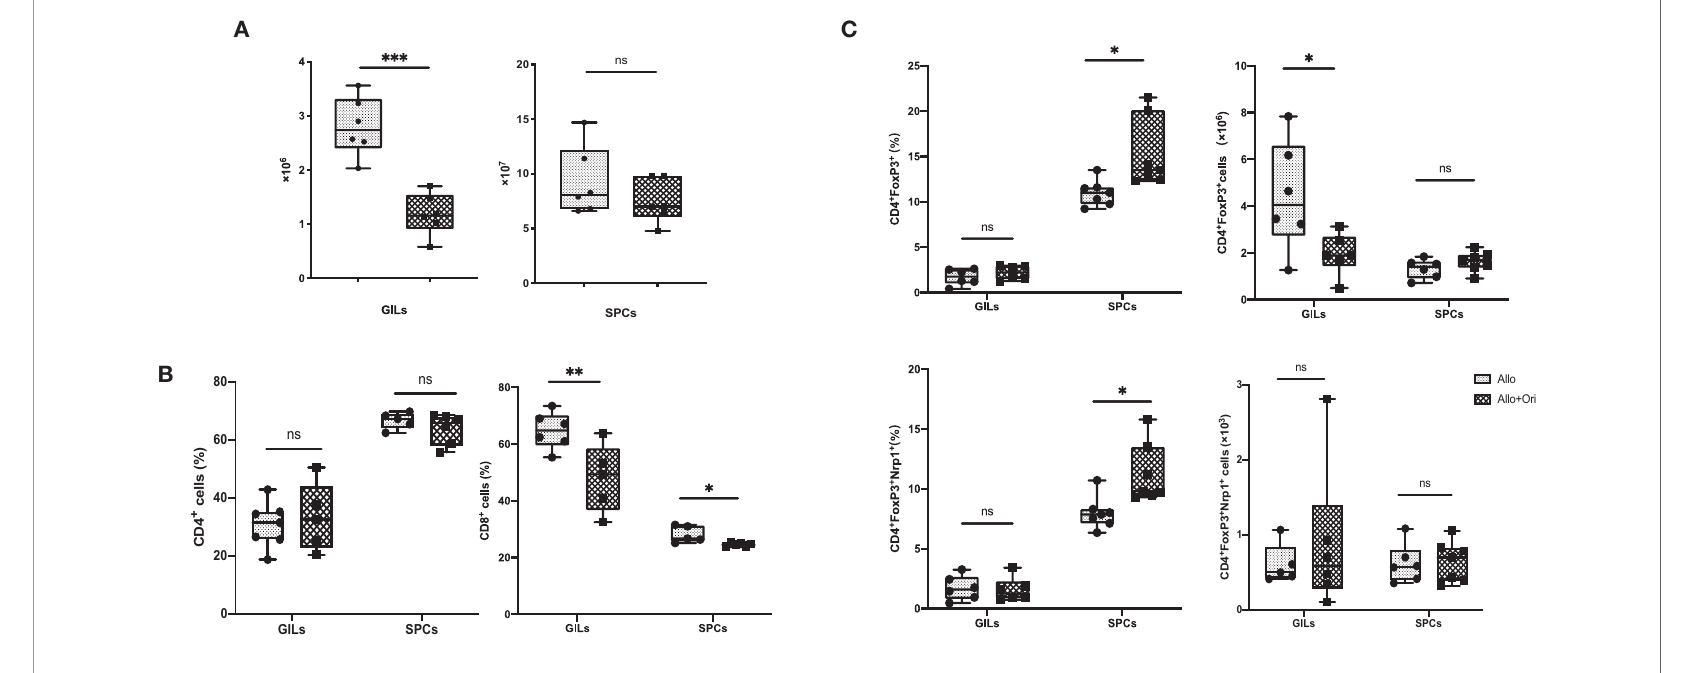
FIGURE 3 | The management of Ori induced alternation of the in fi ltrating T cells and Treg in GILs and SPCs. Spleens and cardiac grafts were harvested on POD7 from vehicle control (Allo) and Ori-treated (Allo + Ori) groups. SPCs and GILs were isolated, multiply stained with mAb, and then assessed by FCM. Stained GILs and SPCs were gated on lymphocyte live cells. Gating strategy is shown in Supplementary Figures S1, S2 . (A) The total cell numbers of the SPCs and GILs in Allo and Allo + Ori groups. (B) The frequencies and absolute numbers of CD4 + and CD8 + T cells in SPCs and GILs from Allo and Allo + Ori groups. (C) The frequencies and absolute numbers of Tregs (CD4 + FoxP3 + and CD4 + FoxP3 + Nrp1 + T cells) in SPCs and GILs from Allo and Allo + Ori groups. Values are shown as the mean ± SD; * p < 0.05, ** p < 0.01, *** p < 0.001, ns, no signi fi